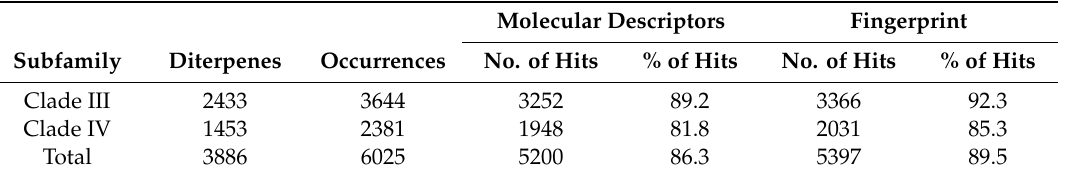
Table 2. Results of the self-organizing map with the values of the occurrences and the number of correct hits for clade III (Nep) and clade IV (Aju, Lam and Scu) of the family Lamiaceae, using the descriptors generated by the program DRAGON 7.0 [24].